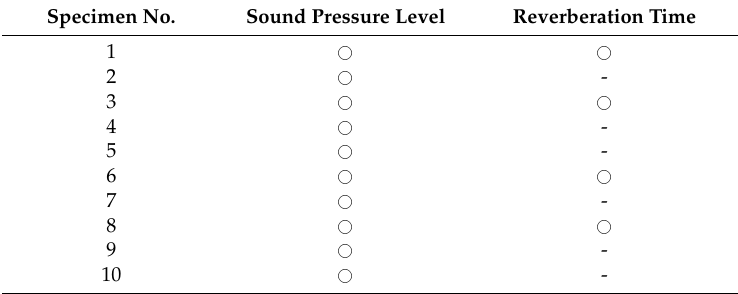
Table 3. Measurement pattern of sound pressure level and reverberation time.